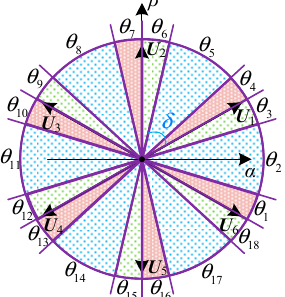
Figure 7. The optimized sector division proposed in this paper.